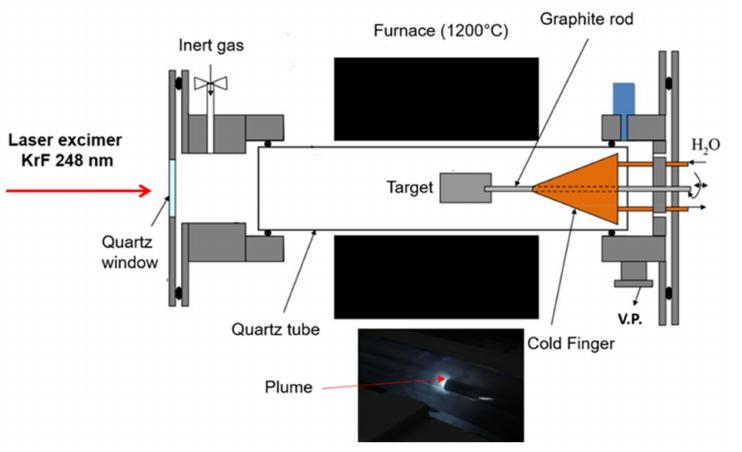
Figure 1. Self-designed reactor for Pulsed Laser Deposition (PLD)—patent pending, in inset the plume ejected from